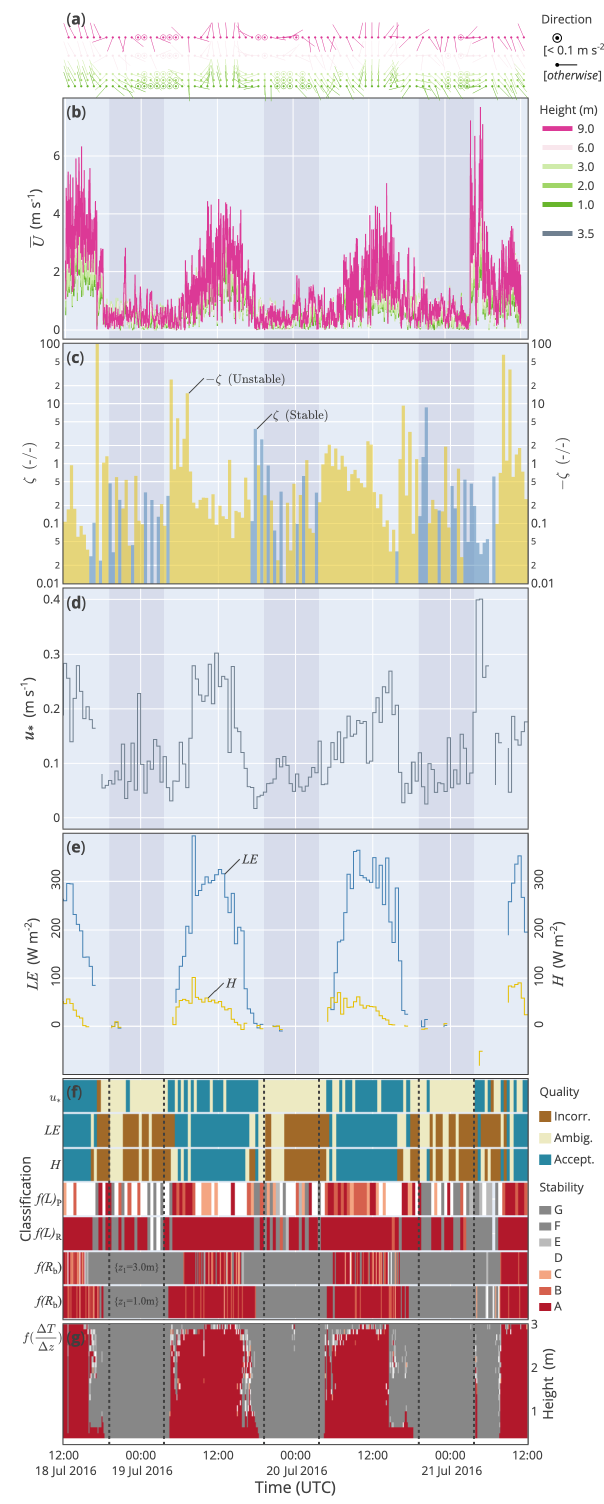
Figure 3. The 1min mean of (a) air temperature, (b) air temperature from fibre-optic cable, (c) air temperature from the speed of sound, (d) surface brightness temperature from radiance (e) net short-wave radiation, R ns , and net long-wave radiation, R nl , terms, and (f) rel- ative humidity and precipitation.